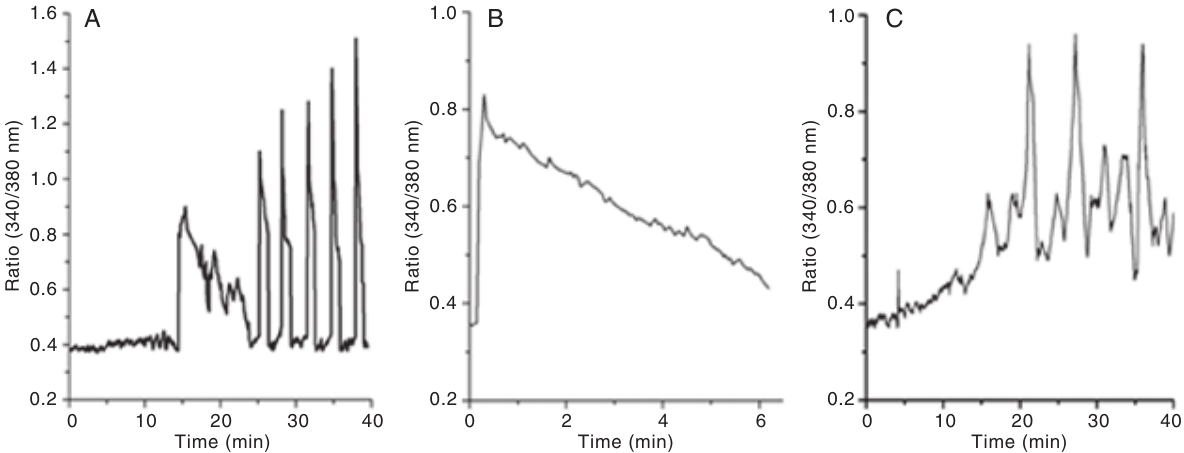
Figure 1. Fertilization-, ethanol-, and conditioned medium (CM)-induced [Ca 2+ ] i changes in fura-2-AM-loaded mouse oocytes. A, During in vitro fertilization, sperm triggered an initial [Ca 2+ ] i transient that was followed by a series of regular and high [Ca 2+ ] i oscillations. B, A single rapid [Ca 2+ ] i rise was observed in 7% ethanol-treated oocytes, which decreased slowly. C) The type of [Ca 2+ ] i changes in CM-treated oocytes was similar to that induced by sperm. The amplitude of the initial [Ca 2+ ] i transient was lower than the subsequent [Ca 2+ ] i oscillations, whereas the oscillations induced by CM were of lower amplitude and longer duration than those induced by